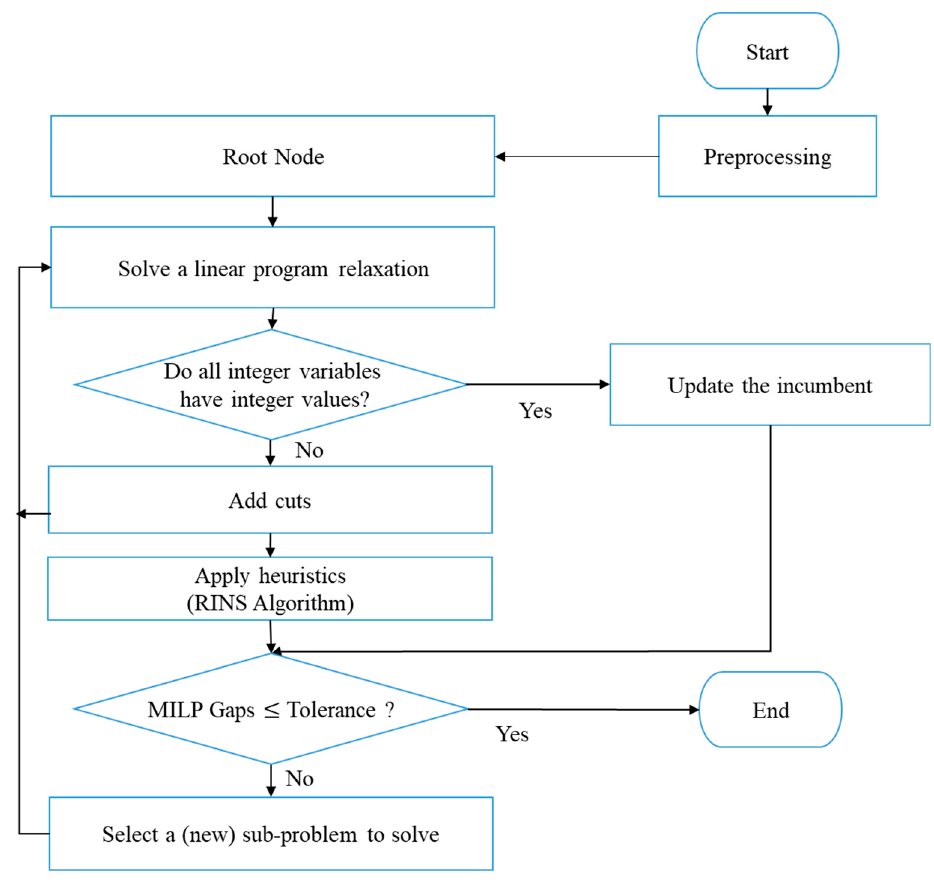
Figure 3. Flow chart of MILP optimizer in CPLEX (Adapted from [35]). MILP, mixed integer linear program.